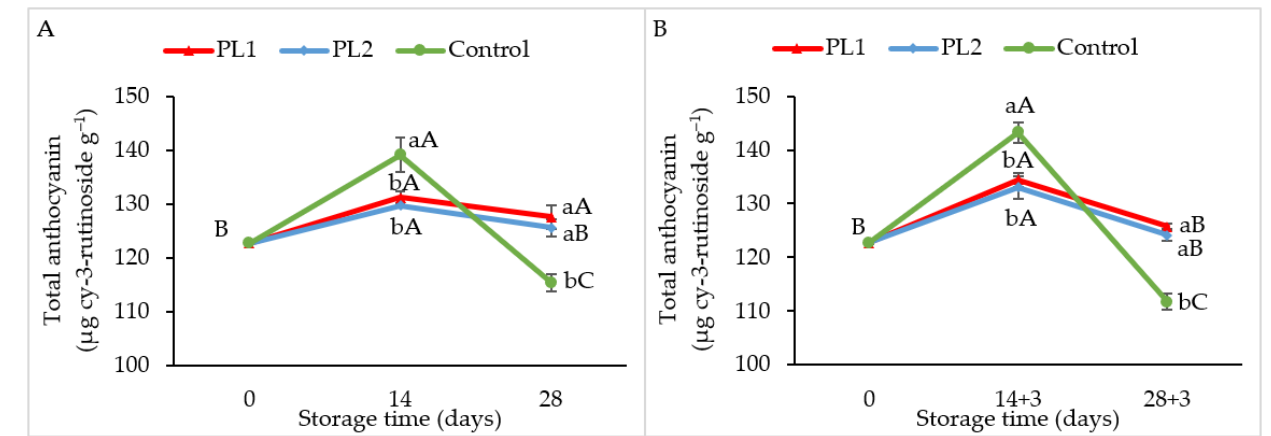
Figure 5. Total anthocyanin changes during cold storage ( A ) and shelf life ( B ). Data are the mean ± SE of three replicates of twenty-two fruits. Different uppercase letters indicate significant differences for each atmosphere composition during storage, and different lowercase letters indicate significant differences among atmosphere compositions for each sampling date at p < 0.05.